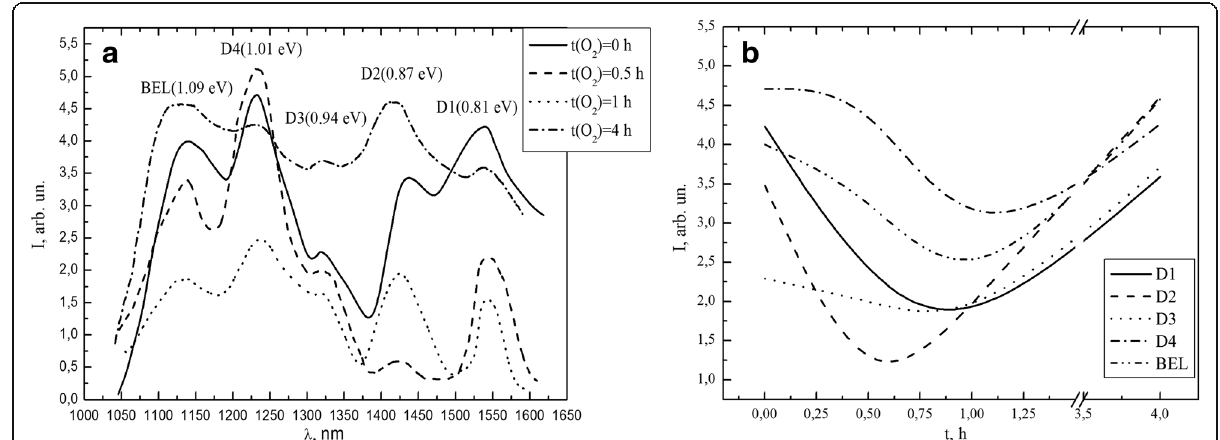
Fig. 3 Change of EL spectrum ( a ) and change in the magnitude of peaks D1 – D4 and BEL ( b ) samples subjected to plastic deformation ( N d ~10 7 cm − 2 ) at different time of high temperature annealing ( T =1000 °C) in FOA